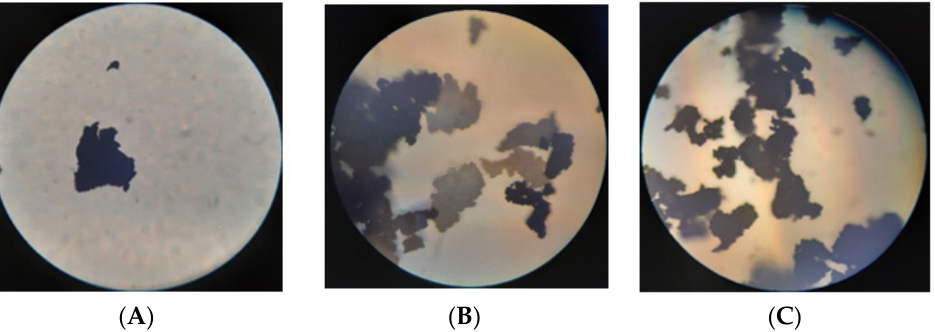
Figure 3. Images: ( A ) APDDR particle; ( B ) mechanical mixture of APDDR and SBS; ( C ) hybrid powder particles (optical microscope MCRT 5000 “Micros”. The magnification is 10 × 10).